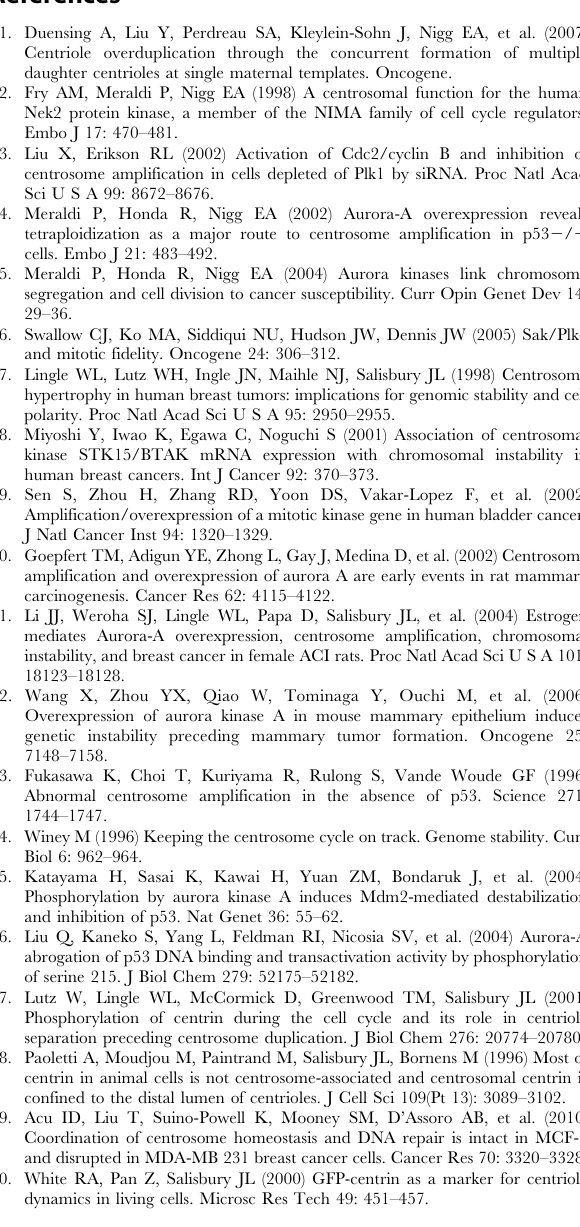
Figure S5 HeLa cells were transfected with either empty pEGFP-C3 or pEGFP-C3-Aurora A constructs and cells were harvested 48 hrs after transfection for immunoprecipitations using anti-centrin and anti-phospho-centrin antibodies. Immunoprecip- itations were separated by SDS-PAGE and blotted with anti- centrin antibody. Note that there is more centrin and phospho- centrin in the pEGFP-C3-Aurora A expressing cells. Figure S6 HeLa cells were processed for immunofluorescence as described in the Material and Methods section. Aurora A was detected with an anti-Aurora A antibody (green) and DNA was counterstained with DAPI (blue). An interphase cell is shown on the left side and an early prophase cell on the right side of the image. Note that Aurora A is much more abundant in the early prophase cell. Scale bar = 10 microns.